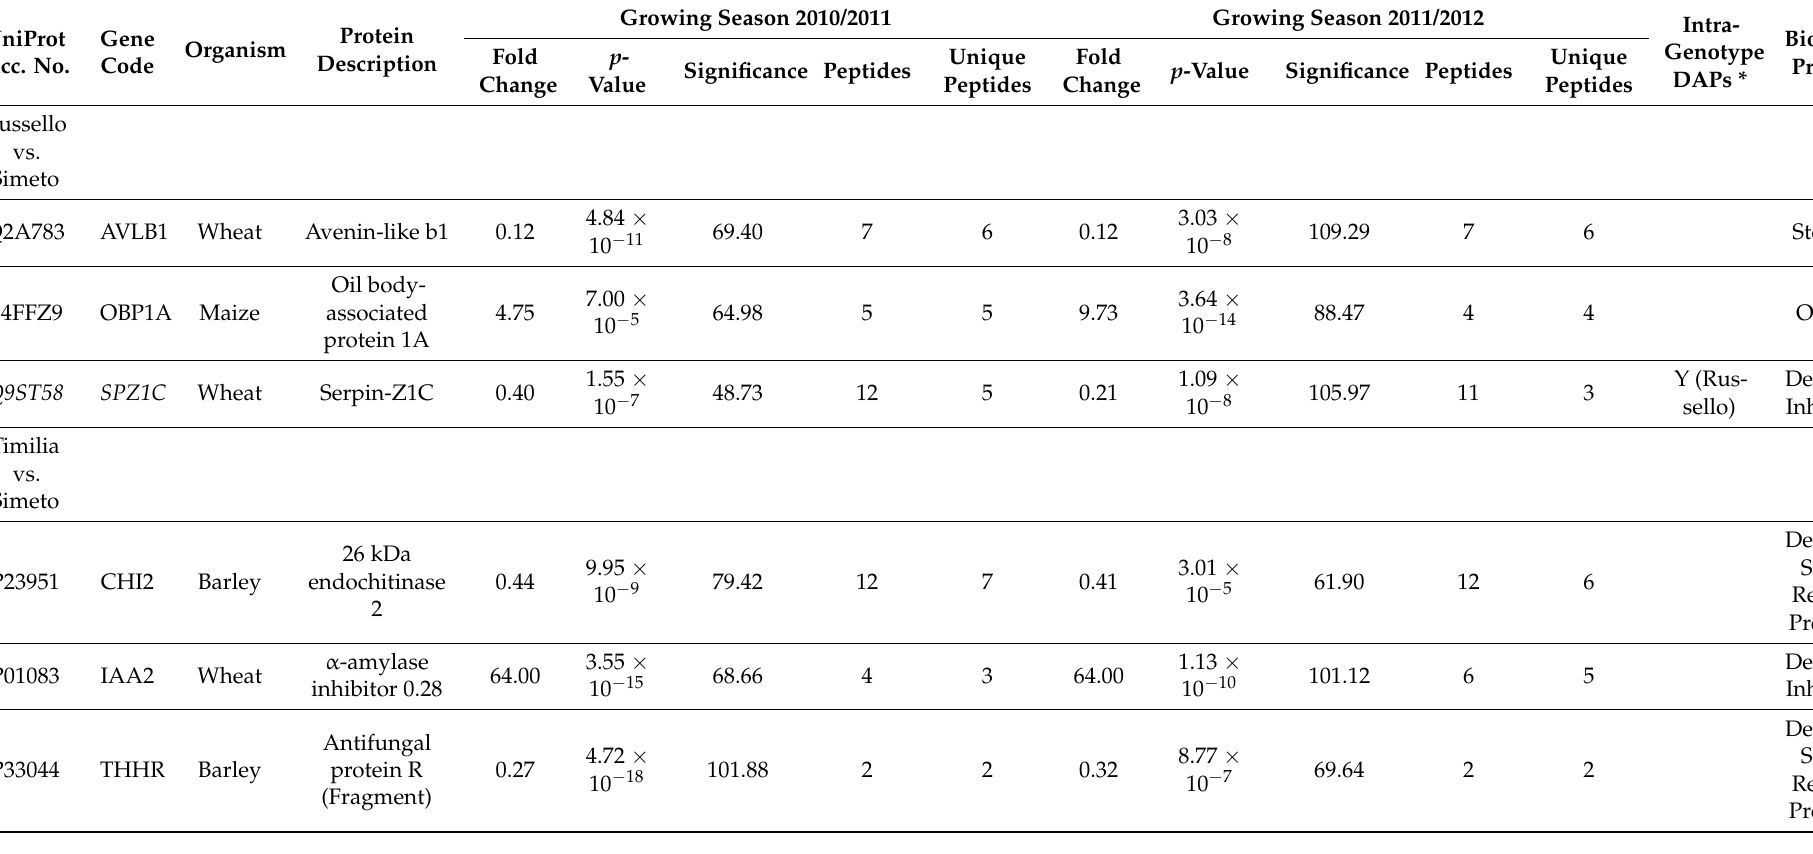
Table 2. List of the proteins detected as DAPs in both the growing seasons investigated: Russello vs. Simeto; Timilia vs. Simeto; Timilia vs. Russello. For each protein is reported: Accession Number as used in the Uniprot database; gene code; organism; protein description; the fold change (if ≤ 0.5 or ≥ 2); p -value observed in the growing seasons 2010–2011 and 2011–2012; significance; the number of the characterized peptides; the number of unique peptides, and the biological process in which it is involved. Proteins that were also detected as intra-genotype DAPs are reported in